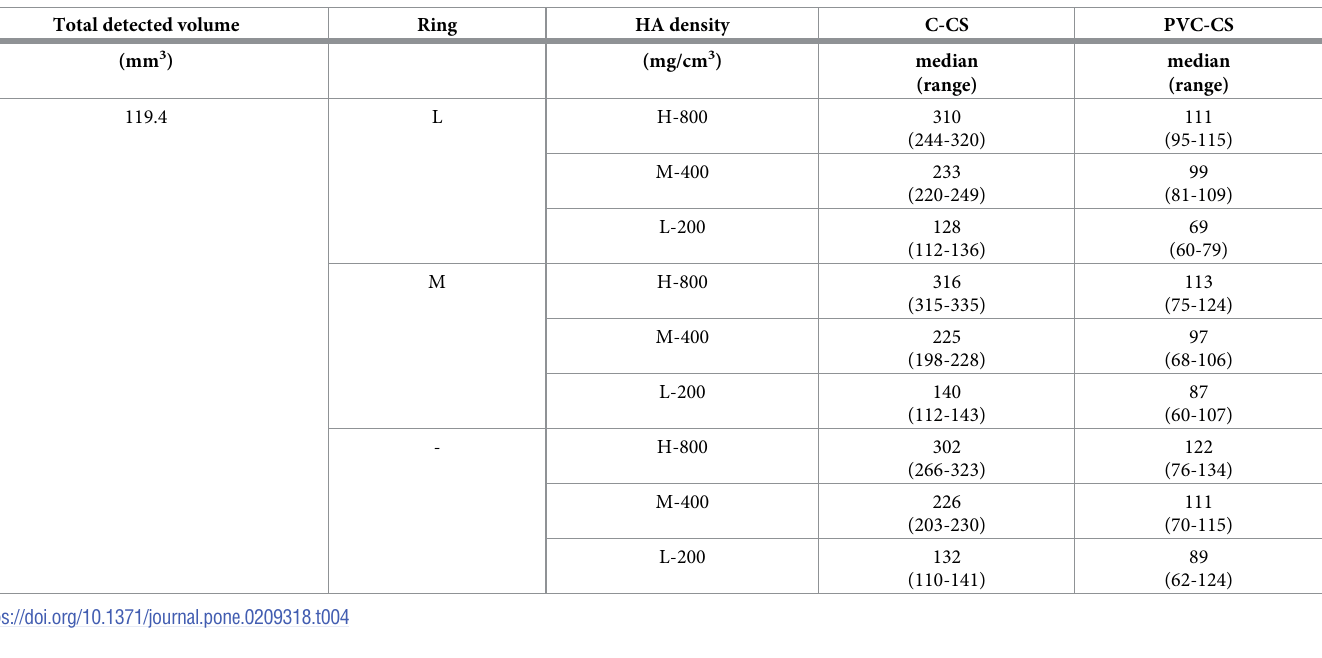
Table 4. Median and range of the determined CAC volumes over five different acquisitions of the CEORA phantom. Results are grouped per ring configuration (No Ring (-), Ring M, Ring L) and HA density (H-800, M-400, L-200 mg/cm 3 ). Calculated values were determined using C-CS and PVC-CS. The median and range values have been rounded for easier presentation.